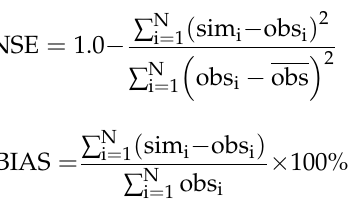
Table 3. Parameters, meanings and calibrated values of CLM model.